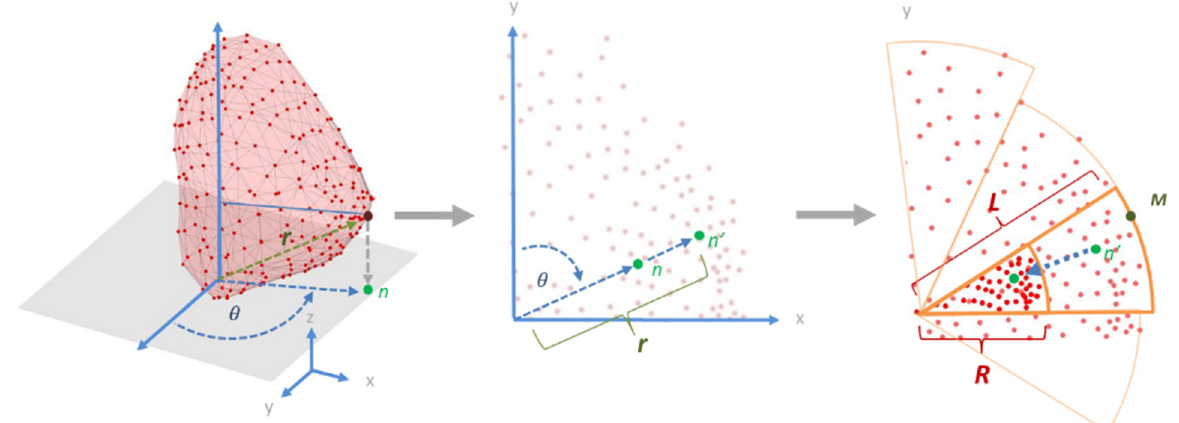
Figure 6. Registration of epicardial notes to the 2D plane. The apex of the heart was used as the origin of the coordinate system. The nodes were then projected onto the x – y plane at n and then the selected node was extended along the vector between the tip and n until the distance between the origin and node was r , where r is the distance between the origin and the epicardial node; the final location is n’ on the x – y plane. The scatter plot was further shrunk to a circular area by dividing the map into segments. In each section, we found the node M with the maximal radius L and then shrunk this node concentrically to a position with radius R . For the rest of the nodes in this segment, we reduced their radius so that the ratio of the new radius to the old radius was retained (equal to L/R ). The arc of the segment in this figure is 30°.